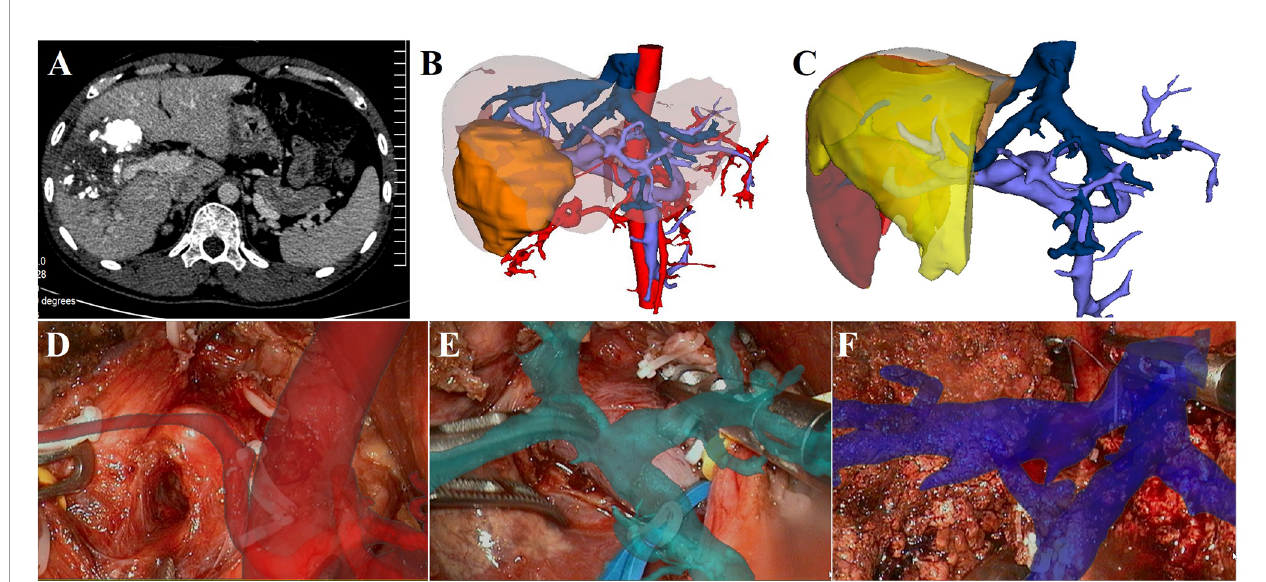
FIGURE 2 | LARN-assisted right hepatectomy. (A) , enhanced CT indicated that the lesion was in the right liver, and it was closely related to the right PV. Iodide oil deposition was found inside the lesion. (B) , The 3D reconstructed model showed the relationship between the lesion and hepatic vessels. (C) , simulated right hepatectomy was performed, and the residual liver volume ratio was 47.1%. (D) , intraoperative navigation of the right hepatic artery. (E) , intraoperative navigation of the main PV and the right PV. (F) , intraoperative navigation of right hepatic